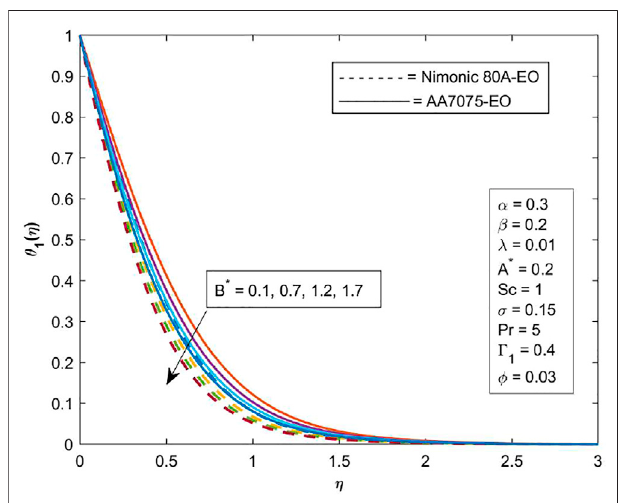
FIGURE 3 | Provocation of B p on θ 1 .